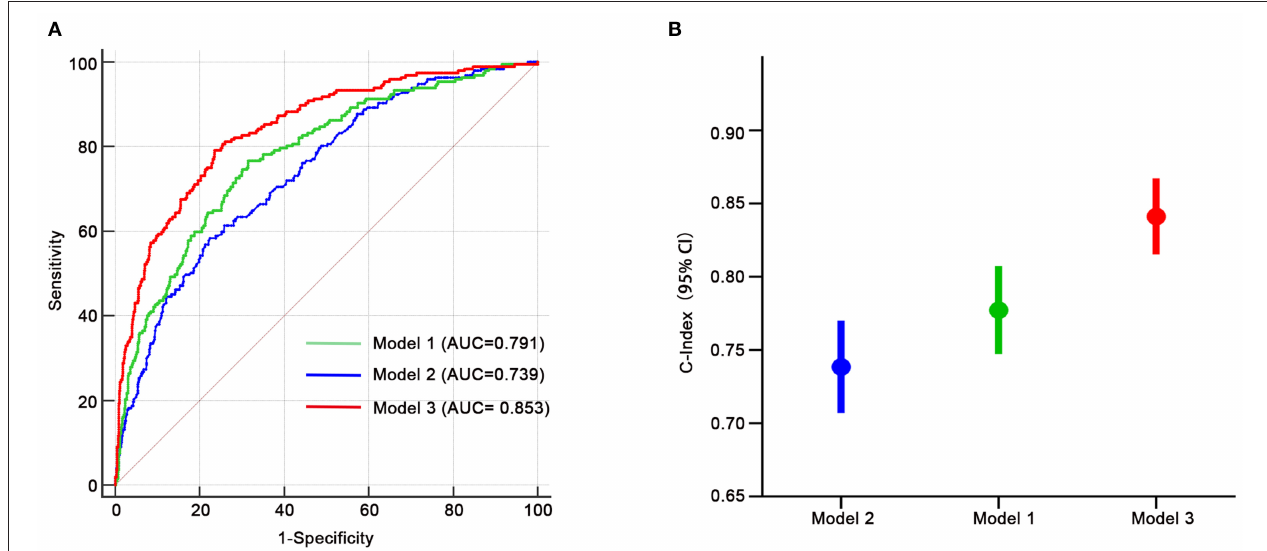
TABLE 8 | Discrimination power analysis of three models using cross-validations. Groups Training set Validation set C-Index 95% CI P- value C-Index 95% CI P- value Model 1 0.764 0.719–0.80 Reference 0.793 0.749–0.832 Reference Model 2 0.749 0.703–0.791 0.678 0.727 0.679–0.771 0.124 Model 3 0.841 0.801–0.875